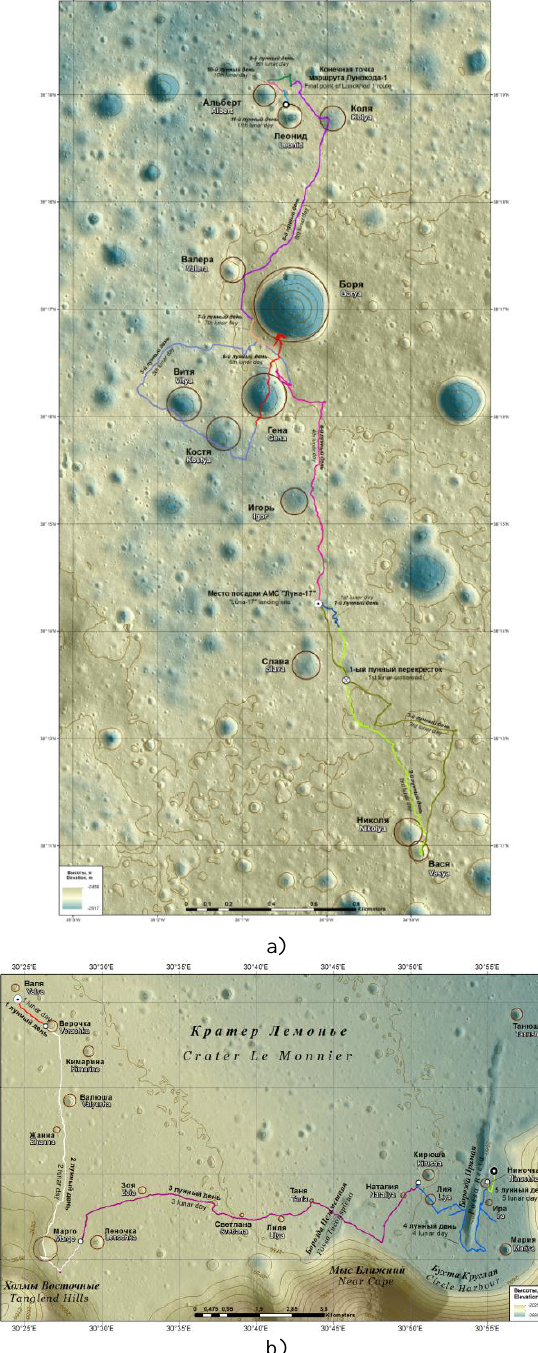
Figure 2. A layout maps of rover traverses based on high resolution DEMs from LRO NAC stereo processing: a) Luna-17 landing area (Lunokhod-1); 2) Luna-21 landing area